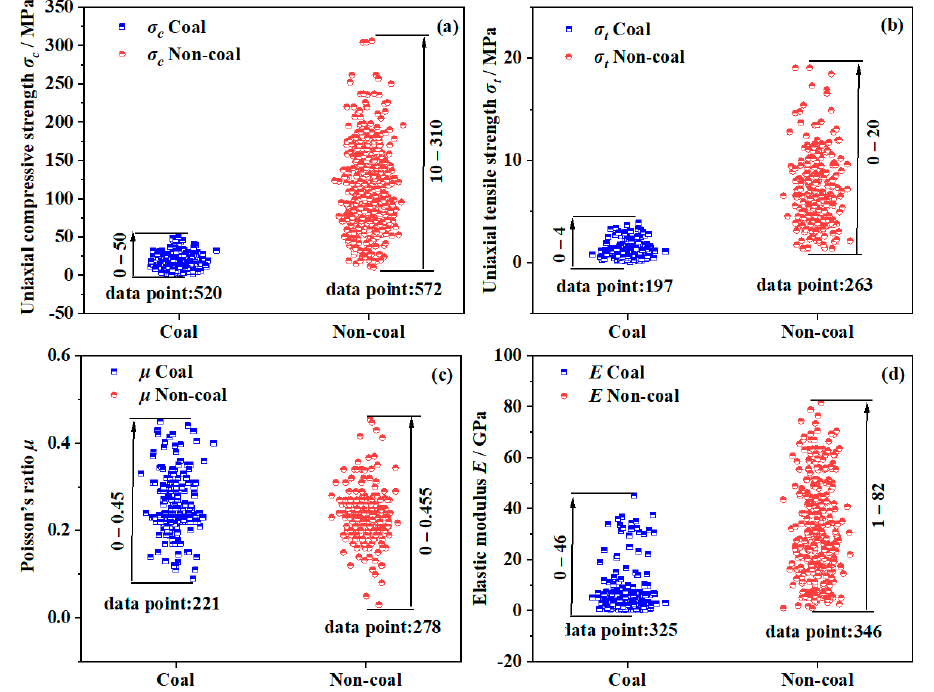
Figure 3. Statistics of basic mechanical parameters of coals and non-coal rocks: ( a ) uniaxial compressive strength σ c , ( b ) uniaxial tensile strength σ t , ( c ) Poisson’s ratio µ , and ( d ) elastic modulus E.